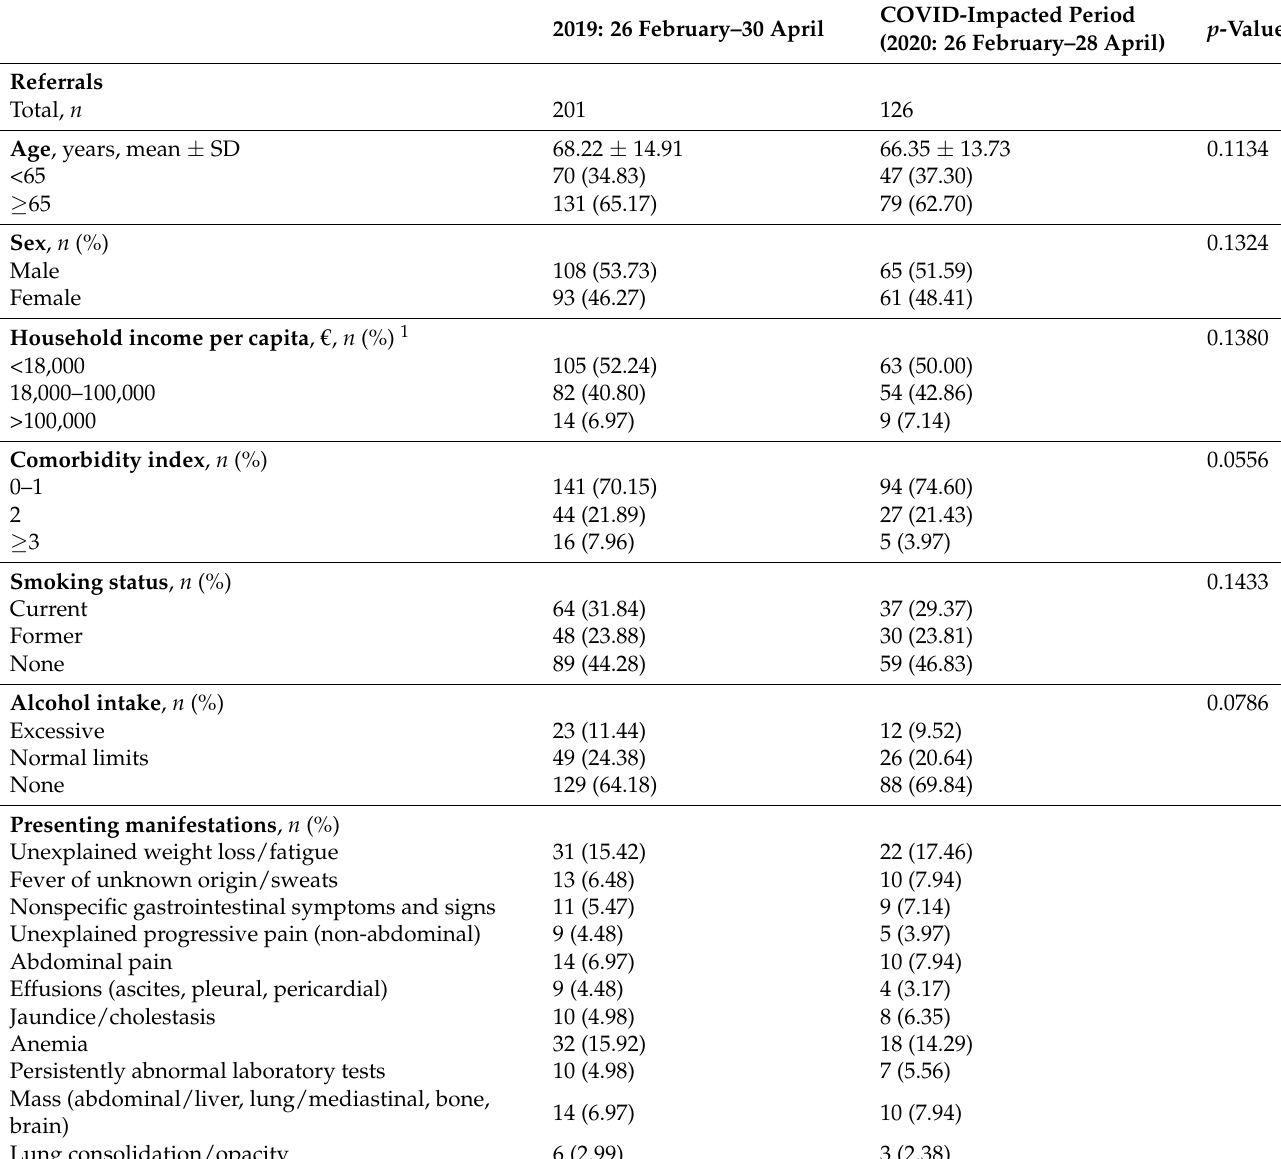
Table 1. Characteristics of patients referred to the Quick Diagnosis Unit during the COVID-impacted period and the same period in